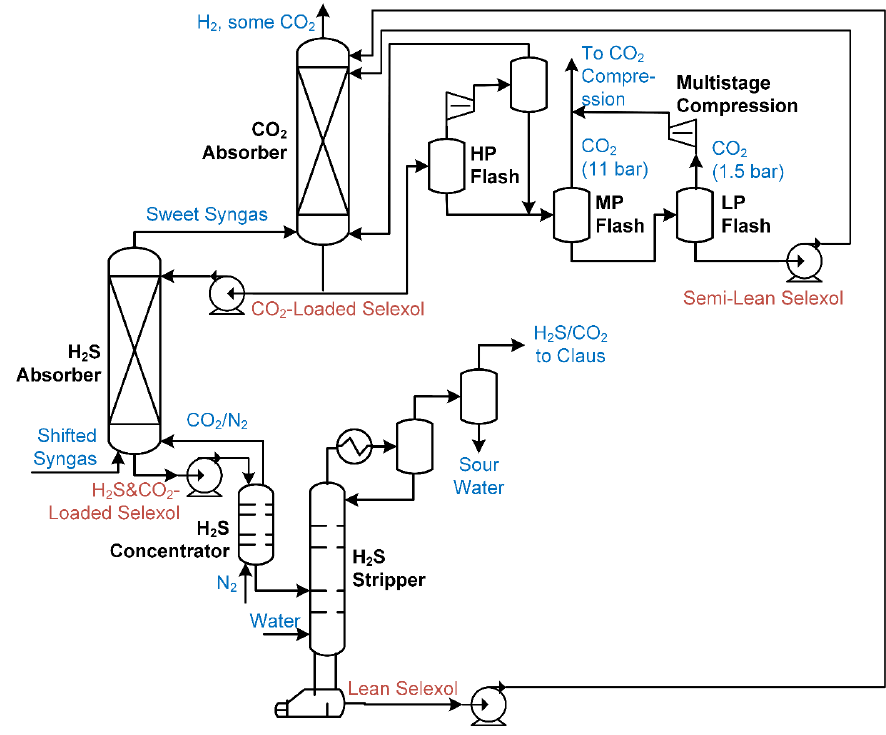
Figure 4. An example CO 2 removal process for IGCC, based on a combination of [6,11,26].